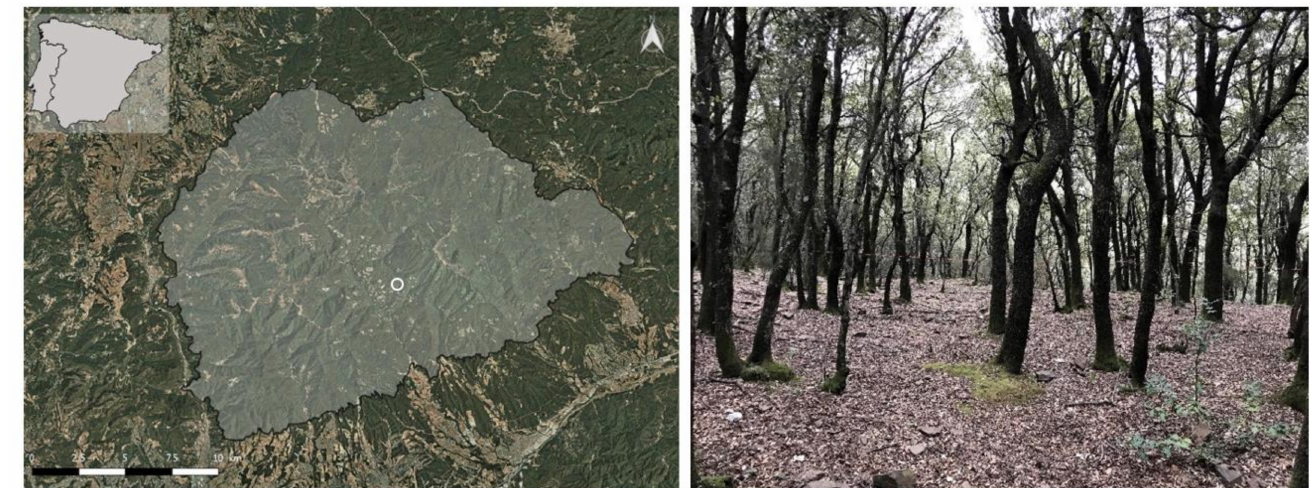
Figure 1. Site location and experimental scenario.